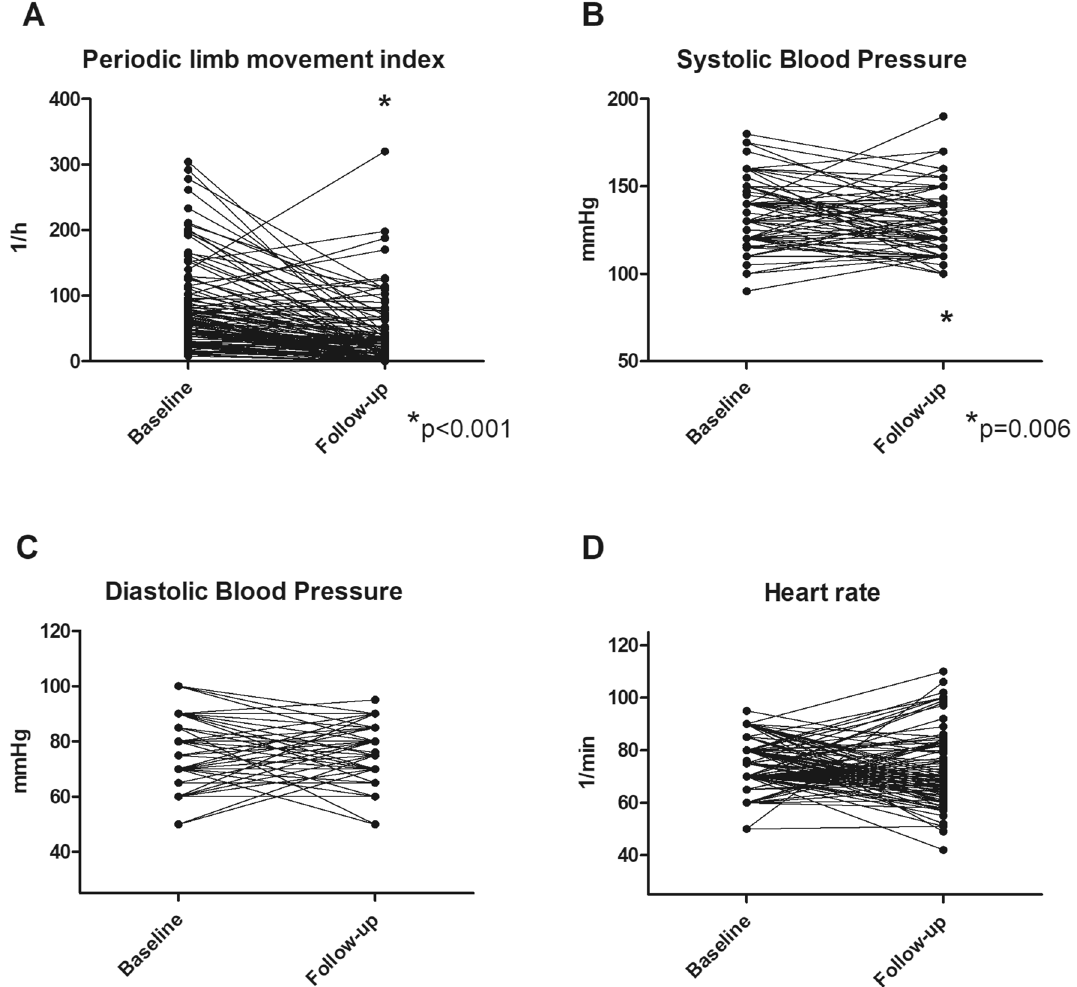
Figure 1. Individual course of ( A ) periodic limb movement index (PLM index), ( B ) systolic office blood pressure (SBP), ( C ) diastolic office blood pressure (DBP), and ( D ) heart rate from baseline to